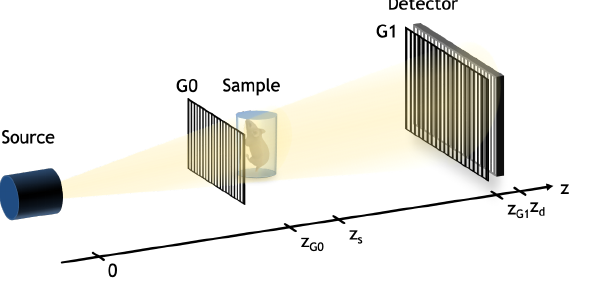
Figure 7. Edge illumination imaging set-up. A beam emitted toward the sample is first split into a thin line beamlet by a vertical grid G0. Those beamlets go through the sample before propagating to the detector plane, where a second grid G1 filters the beamlets that have been deflected by the sample. Several acquisitions are acquired with various positions of G0 and